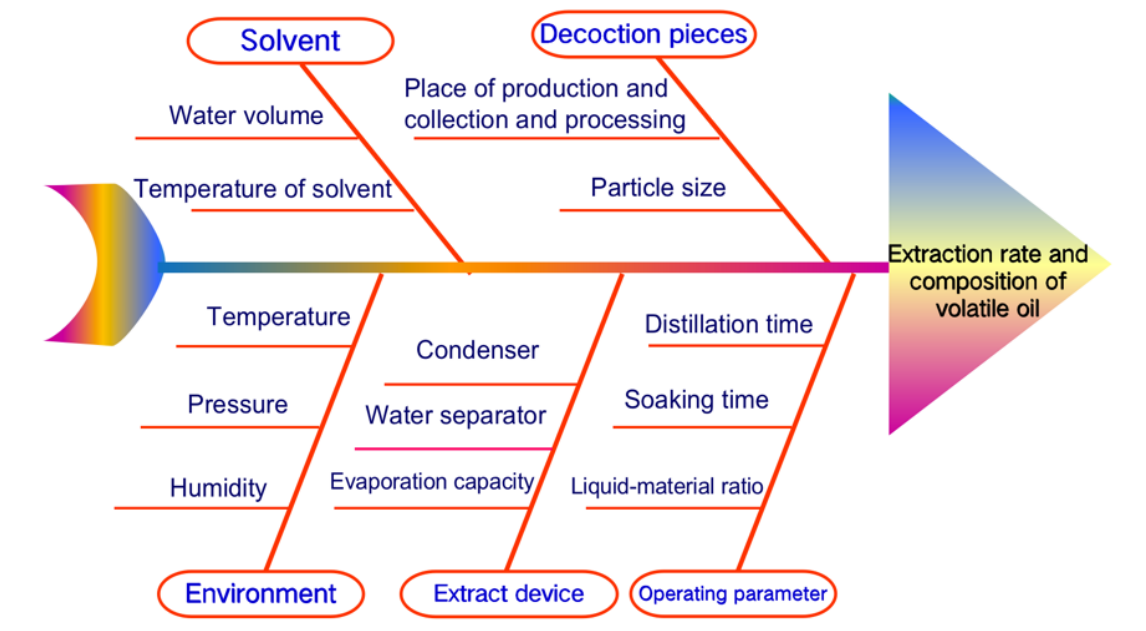
Figure 2. The Ishikawa diagram of the steam distillation process for volatile oil distillation. Next, the Box–Behnken design was used to optimize the distillation process of the volatile oil from Angelicae sinensis Radix with the distillation time, soaking time, and